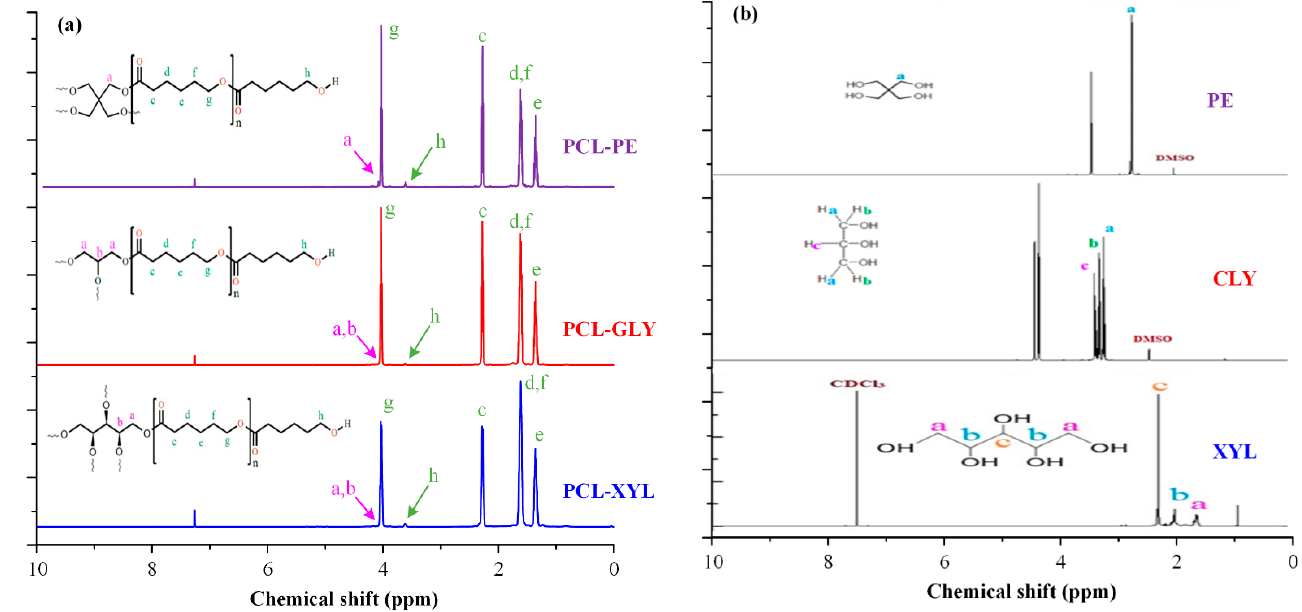
Figure 2. 1 H NMR spectra of three branched PCL-copolymers ( a ) and the neat polyols ( b